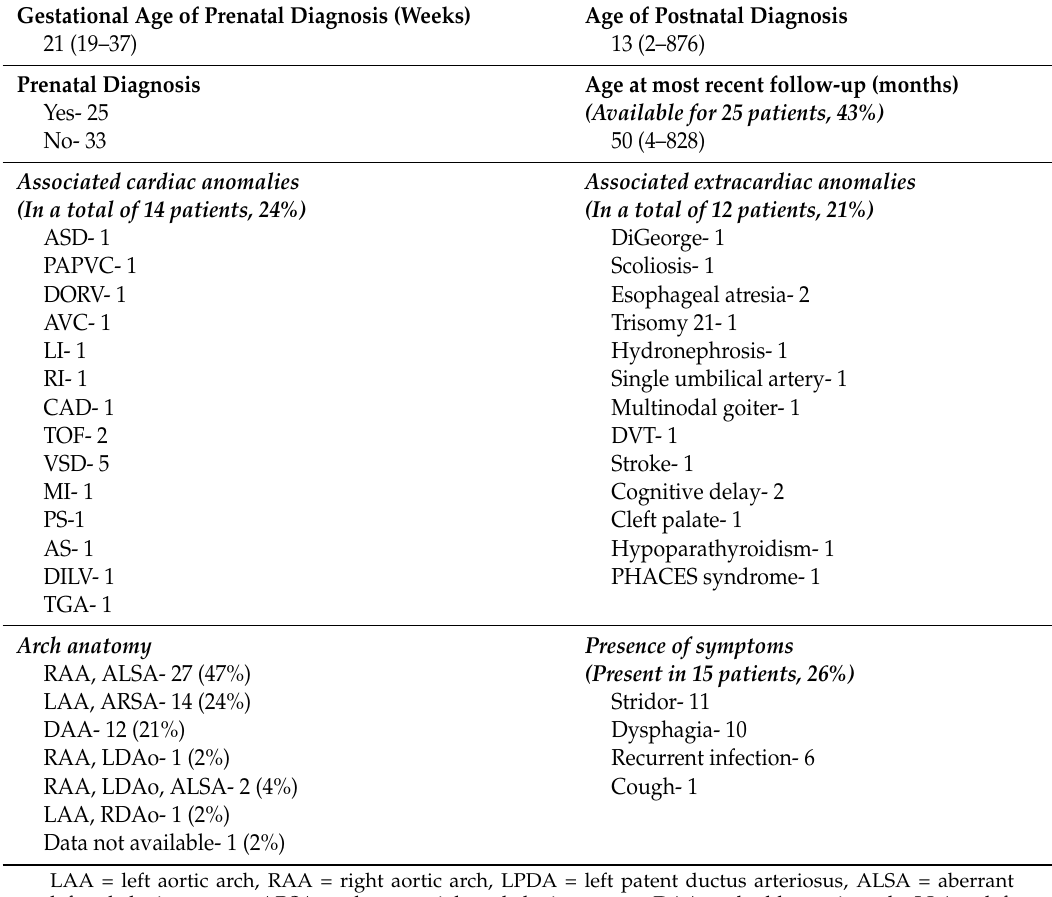
Table 2. Summary characteristics for entire